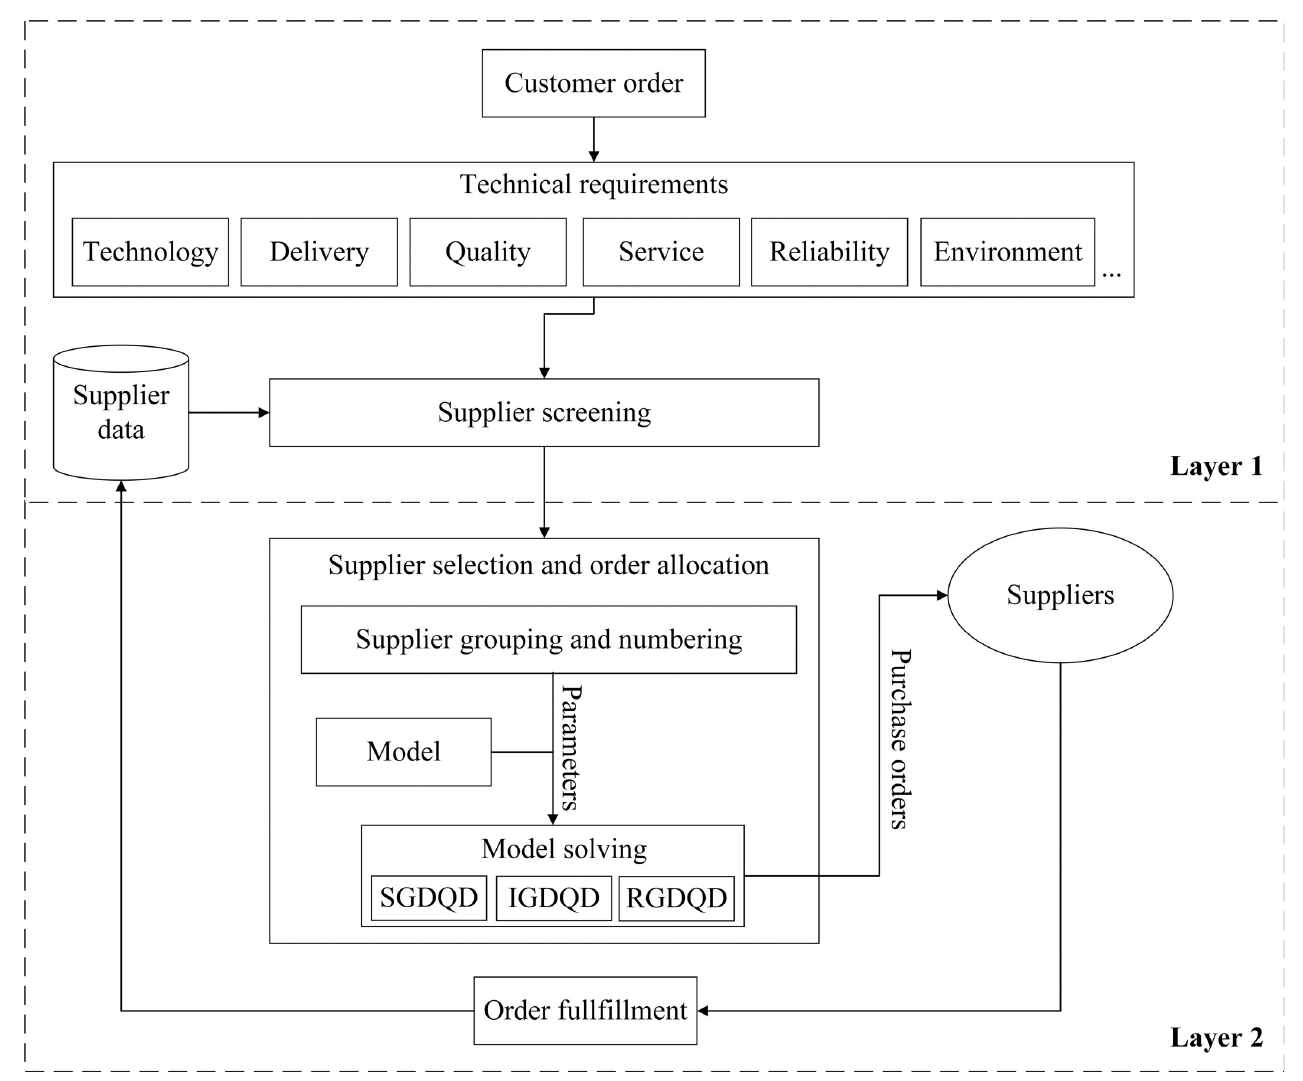
Fig 1. Two-layer